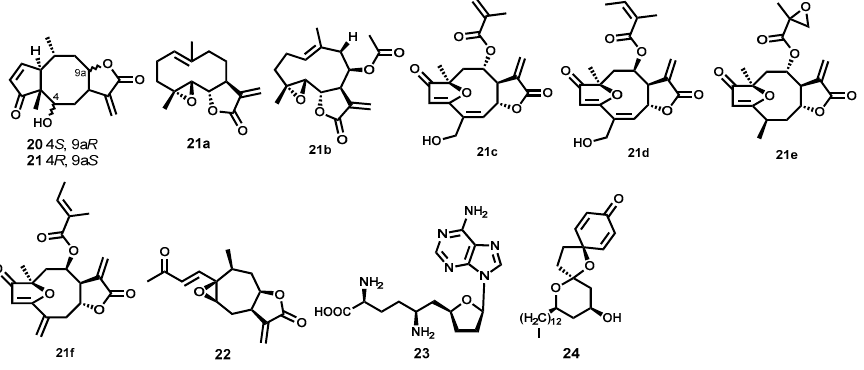
Figure 4. Trypanocidal terpenes and other metabolites.